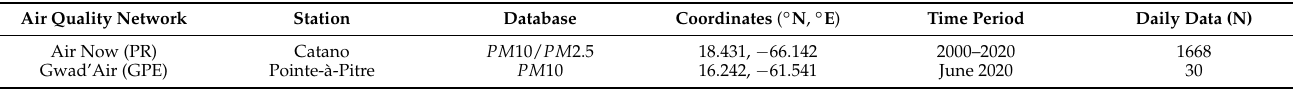
Table 2. Particulate Matter (PM) daily data from PR and GPE. N represents the data point